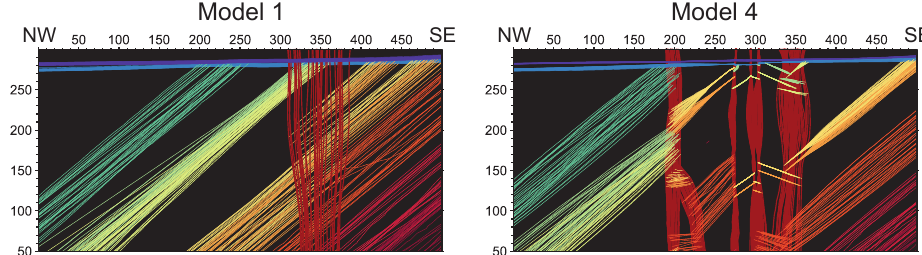
Figure 7. Cross section through Models 1 and 4. The multiple lines show 30 model realizations with shifted faults and horizons (for the location of the cross sections, see Fig. 6). The horizontal lines indicate the land surface (purple) and the base of the Quaternary